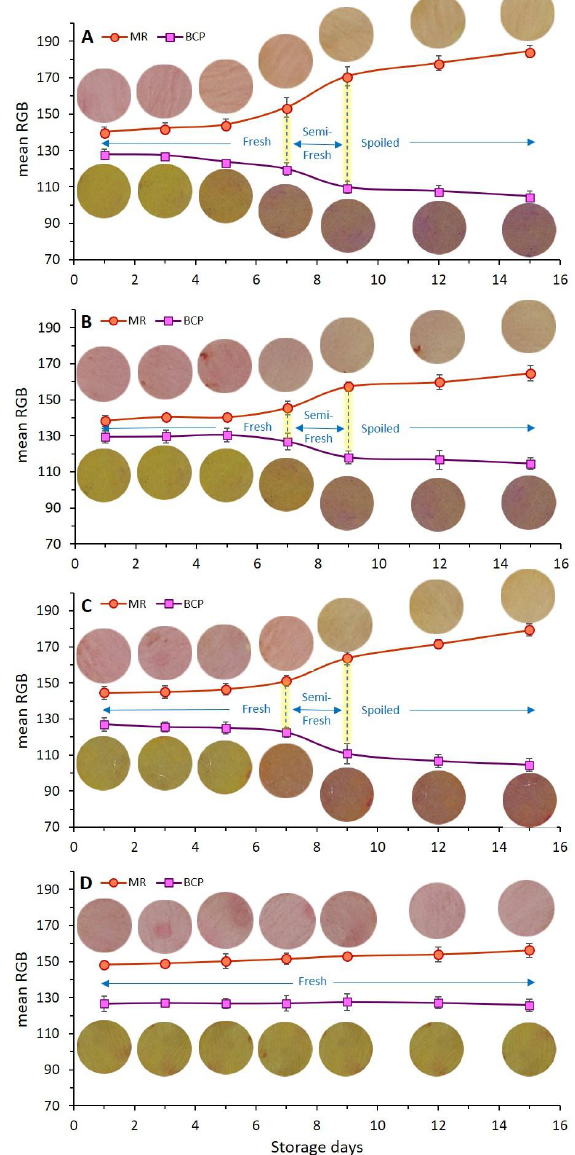
Figure 5. Effect of different types of chitosan coatings incorporating YEO (( A ), control: Ch_0% — YEO_0%, ( B ): Ch_2% — YEO_0%, ( C ): Ch_0% — YEO_0.3%, ( D ): Ch_2% — YEO_0.3%) and chilled storage time on dual-sensors color responses (mean RGB) towards spoiling chicken breast fillets at chilled temperatures. Data are mean of at least triplicate measurements and error bars indicate SDs. MR: methyl red, BCP: Bromocresol purple. (For measurement of the mean RGB of each color sensor, the reader is referred to see Section 2.9 of this article.).